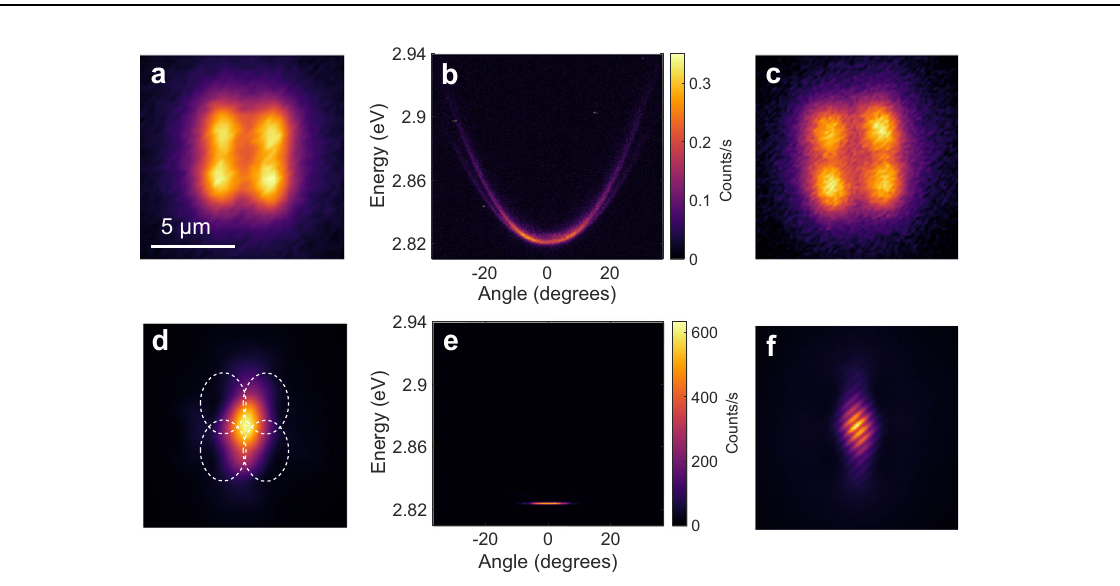
of a square with edges of 2.8 μ m at 0.02 P th . d – f Real-space image, angle-resolved PL,and interferogram at2.1 P th . White dashed ellipses in d indicate the positions of pump spots.